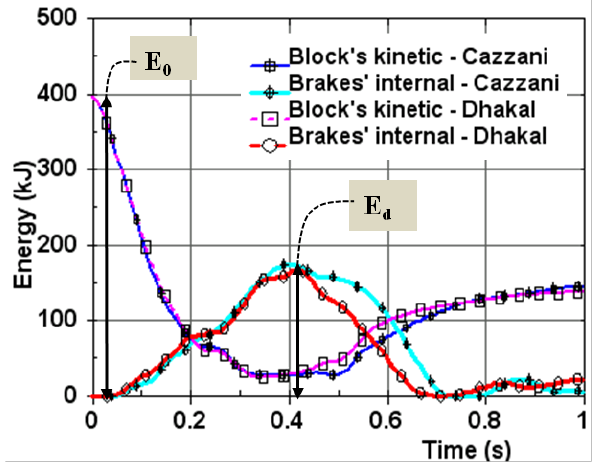
Figure 20. Numerically simulated time histories of energy dissipation by the brake devices having the proposed consitutive models defined by Cazzani-LPR Brake Model and Dhakal-LPR Brake Model and integrated separately into the R-LPR, when subjected to the impact energy of 400 kJ (2.67 times higher than the originally designated system capacity of 150 kJ). The maximum (out-of-plane) displacement response in each case was read approximately the same, about 4.9 m. Correspondingly the maximum tension in the cable and the maximum slip-displacement (again at location M in Fig. 1) were found, respectively, to be 45 kN and 847mm in the case of the Cazzani model while 66.44kN and 767mm in the case of the Dhakal model.